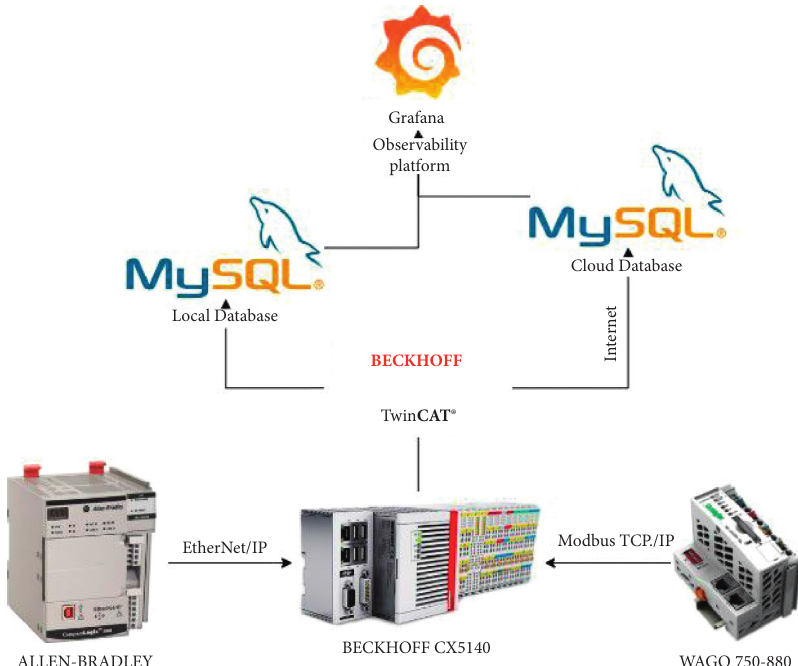
Figure 5: Data flow in the